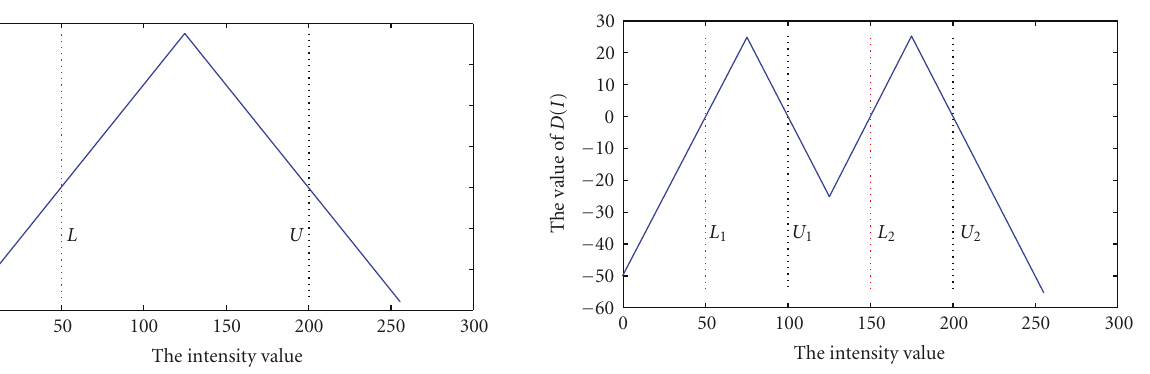
Figure 2: The function D ( I ) is defined by parameters L and U . Figure 3: The function D ( I ) is defined by parameters L 1 , U 1 and L 2 , U 2 .